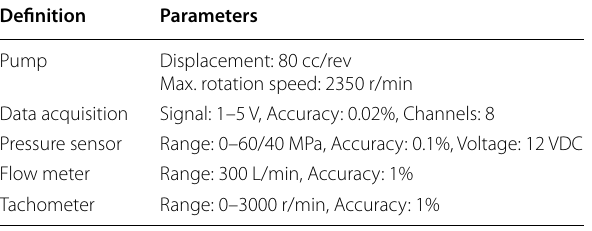
Table 2 Main parameters and size of the experimental platform